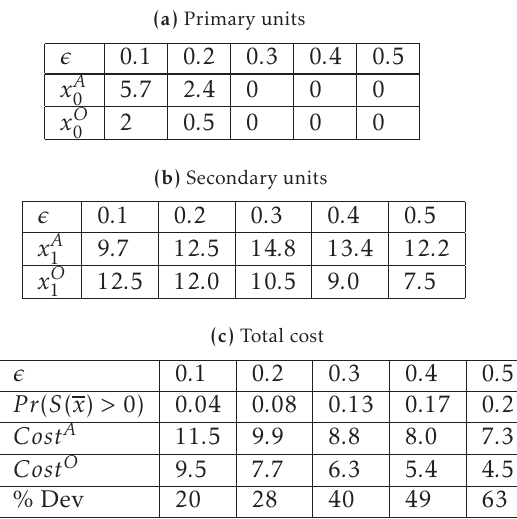
Table 2. Deviation in SPO results when Bernstein approximation is employed. Bandwidth return and demand are modeled as beta distributions.